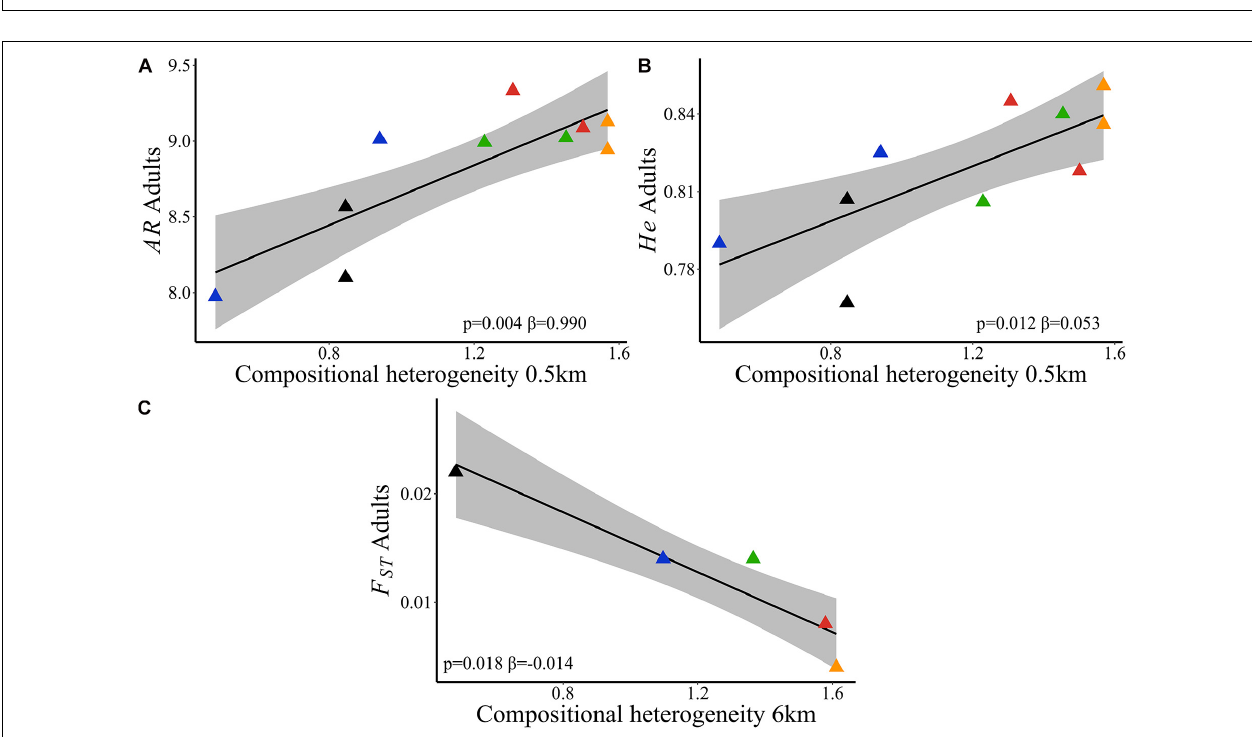
FIGURE 3 | Relationships of adaptive quantitative traits and landscape compositional heterogeneity (SHDI) in Caryocar brasiliense based on 10 sampling sites in the Cerrado biome, Brazil. (A) Evolvability in leaf length ( CV a % LL) and SHDI at node level. (B) Quantitative genetic differentiation in aboveground dry mass ( Q ST ADM) and SHDI at 2 km spatial scale. Black line is the linear regression fit and shaded area is the 95% confidence interval. Triangle color corresponds to the landscape: red = L1; blue = L2; orange = L3; green = L4; black = L5.